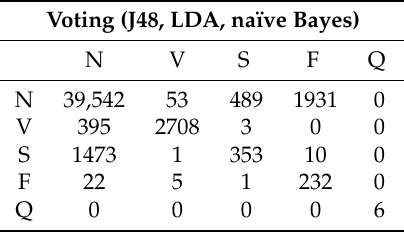
Table 8. Confusion matrix for combining J48, LDA, and naïve Bayes classifiers using a Voting